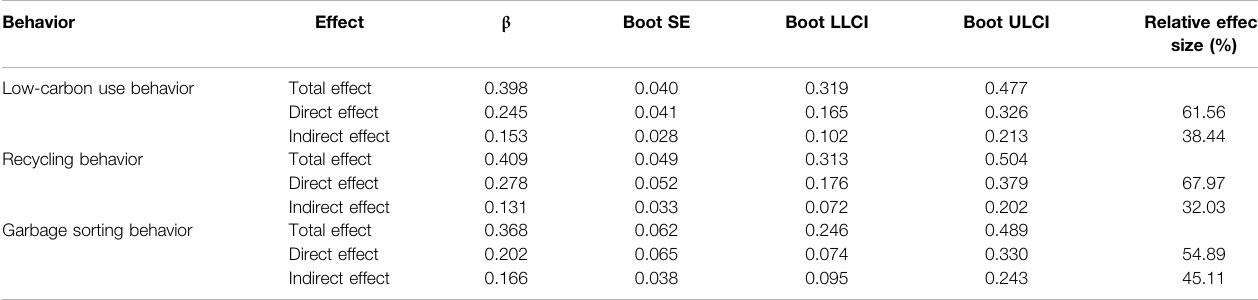
TABLE 6 | The direct and mediating effects of self-ef fi cacy.